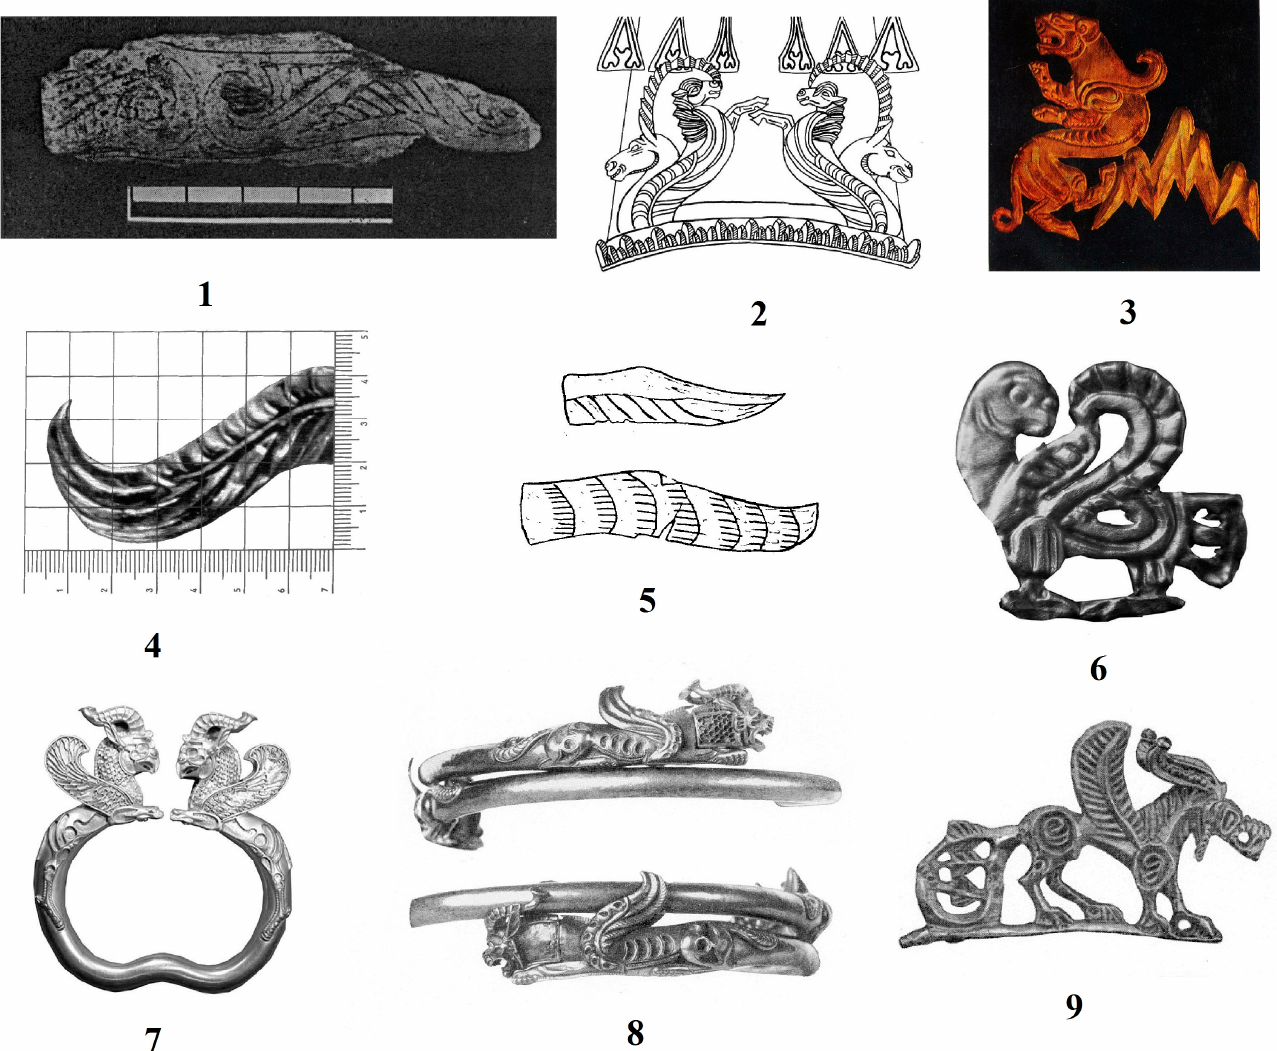
Figure 6. 1—Tuura-Suu burial ground, Issyk-Kul; 2–4—Issyk barrow; 5—Jal-Aryk burial ground, Ketmen-Tyube Valley, western Tien Shan; 6—Zhetytobe burial ground, southern Kazakhstan; 7— Oxus treasure; 8–9—Siberian collection of Peter the Great (1—after Mokrinin and Garushenko 1975; 2–4—after K. A. (Akishev 1978); 5—after K. I. Tashbaeva (2011); 6–7—after M. K. Seitkaliev (2014); 8–9—after S. I. Rudenko